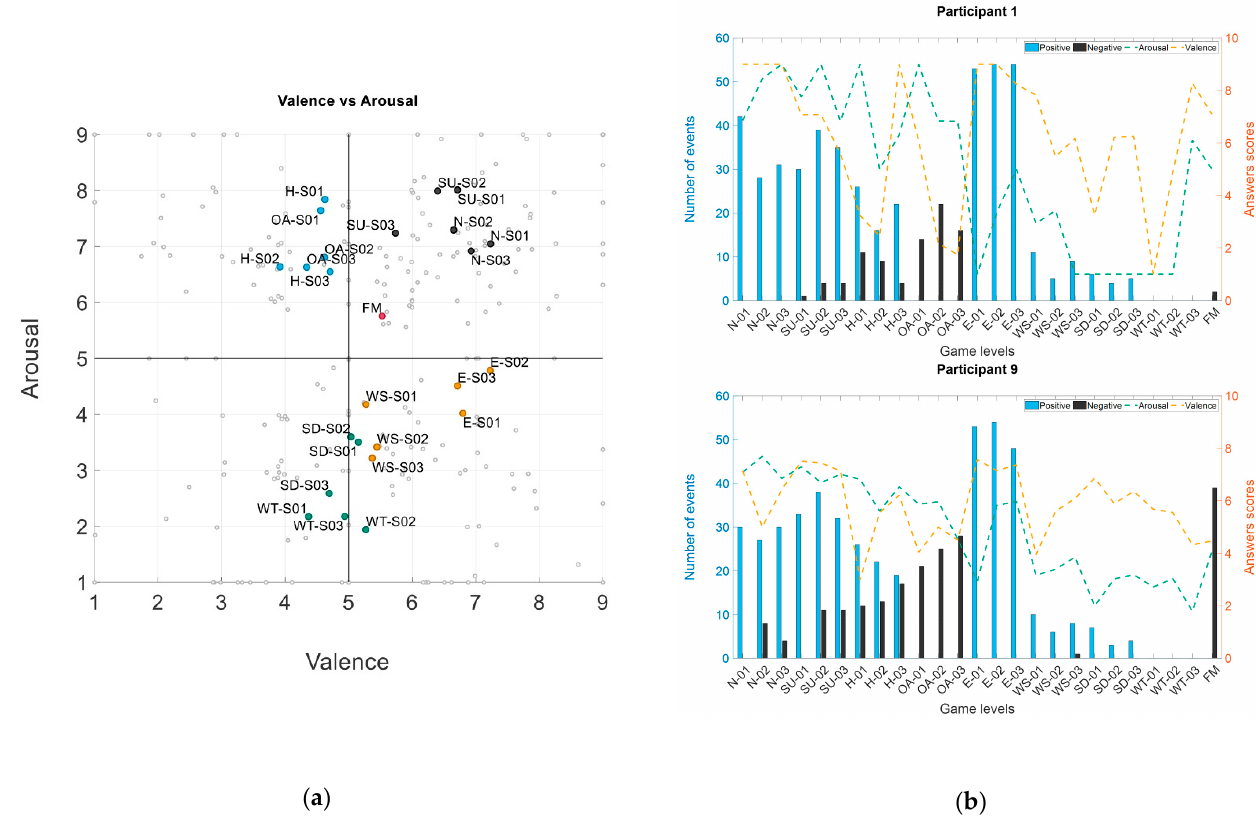
Figure 2. Participants’ information for self-assessment and game events. ( a ) Arousal–valence dispersion. Levels names: N—normal, S01—Stage 01, S02—Stage 02, S03—Stage 03. The colors are related to the emotional quadrants that we intent to induce: high arousal and high valence (HAHV)—black, high arousal and low valence (HALV)—blue, low arousal and high valence (LAHV)—orange, low arousal and low valence (LALV)—green. ( b ) Total amount of positive and negative events obtained by each participant across all the game levels along the arousal and valence responses.